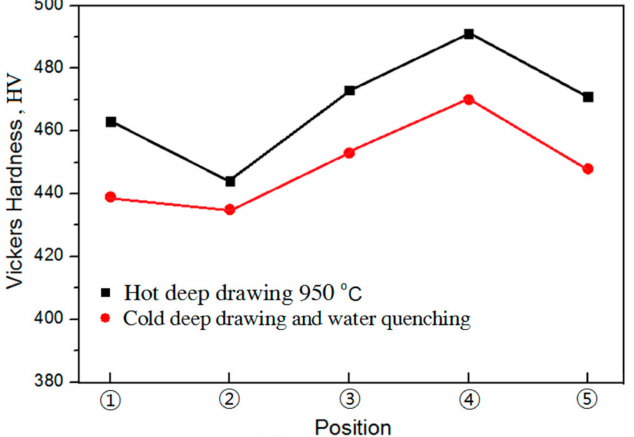
Figure 11. Vickers hardness at different positions of the drawn part for hot deep drawing ( T s = 950 ◦ C) and cold deep